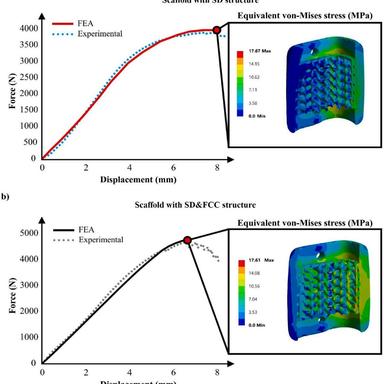
Comparison between the experimental and FEA force-displacement curves, along with the equivalent von-Mises stresses for PCL scaffolds with a) SD structure and b) SD&FCC structure.